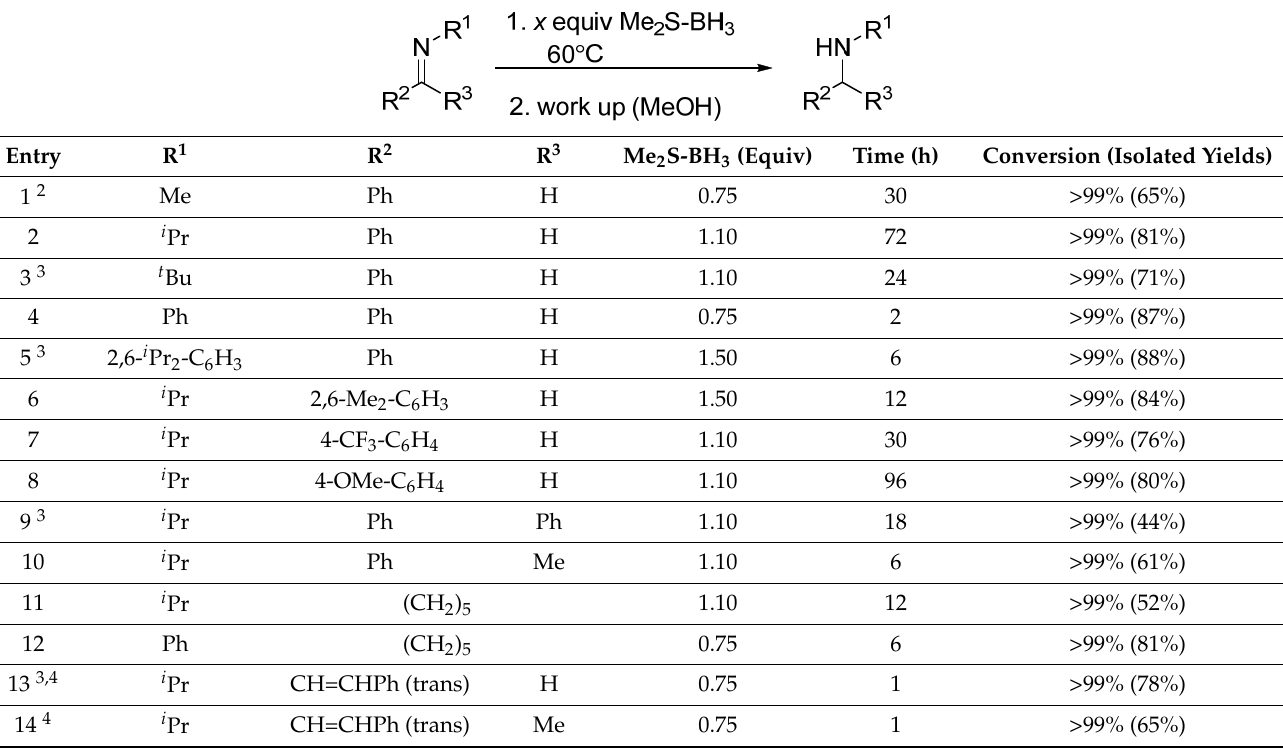
Table 1. Summary of reaction conditions to achieve quantitative conversion of imines 1 .